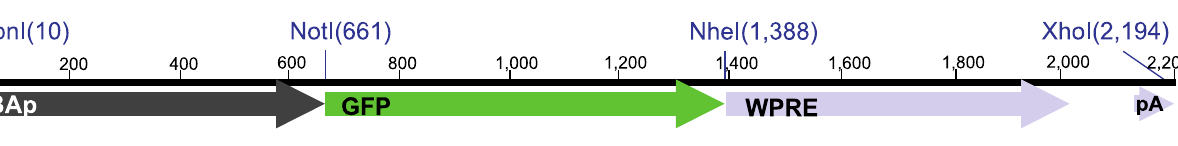
Figure 3. In silico design of a flexible expression cassette. KpnI, NotI, NheI and